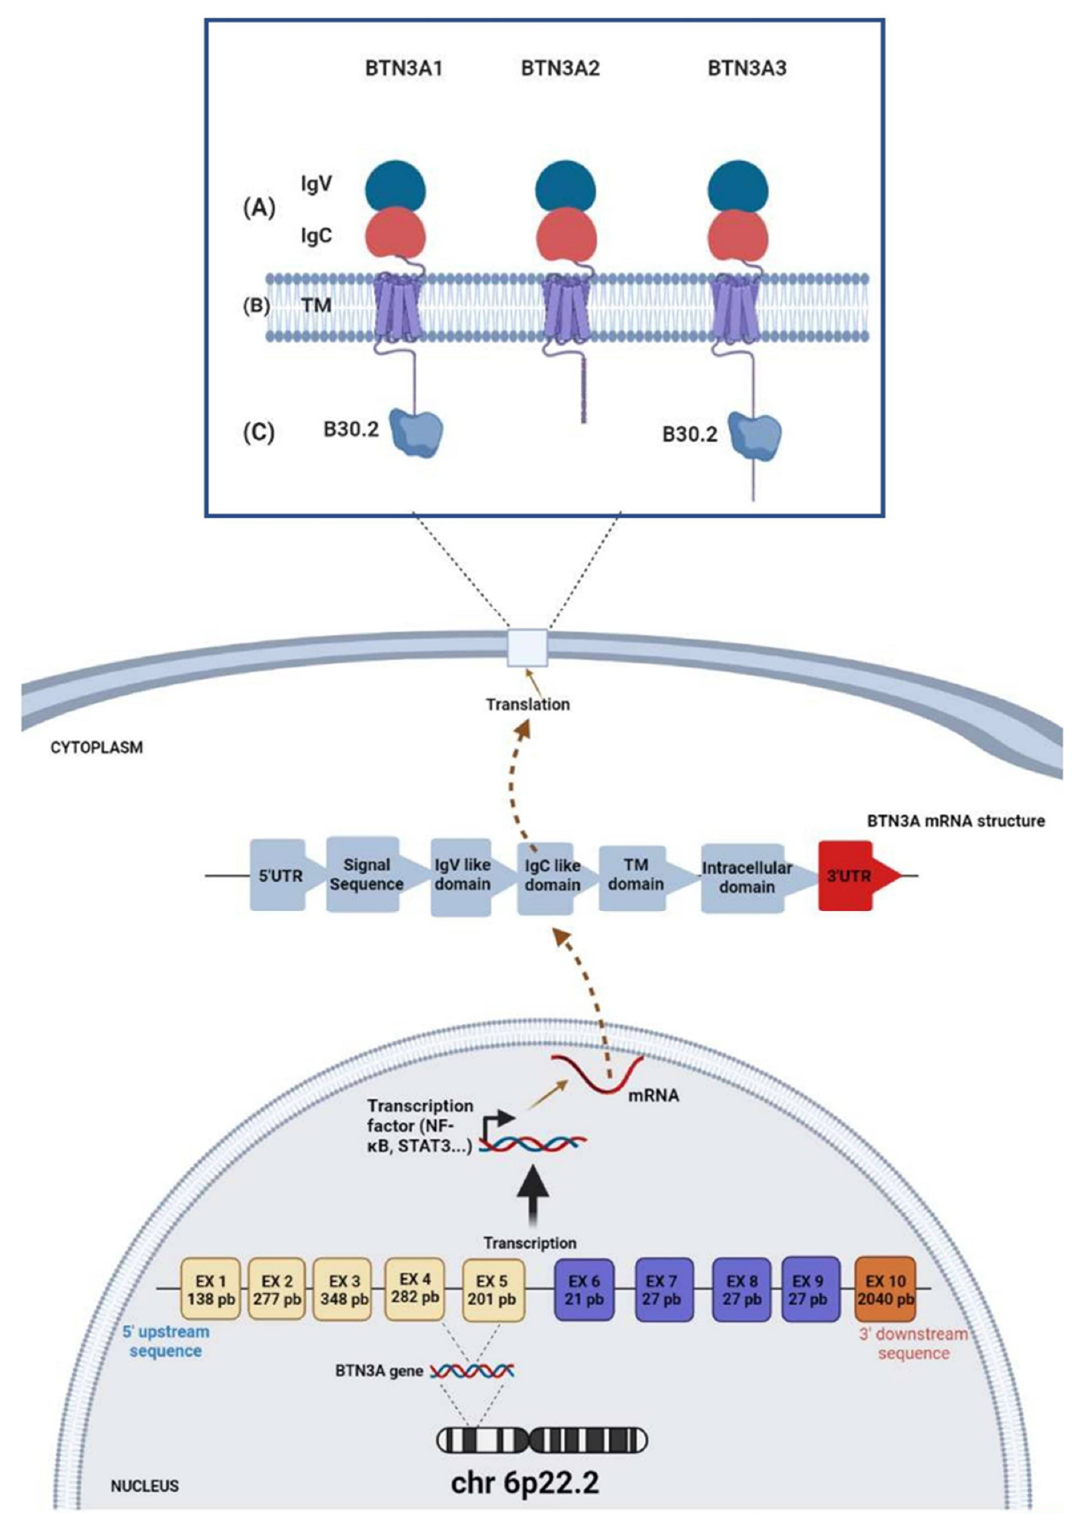
Figure 1. Schematic representation of the CD277/BTN3A gene, mRNA, and protein structural domains. ( A ) The extracellular domain of interaction with the ligand. ( B ) The transmembrane domain. ( C ) The intracellular domain. BTN3A1 and BTN3A3 share the B30.2 domain involved in the interaction with the phosphoantigens.